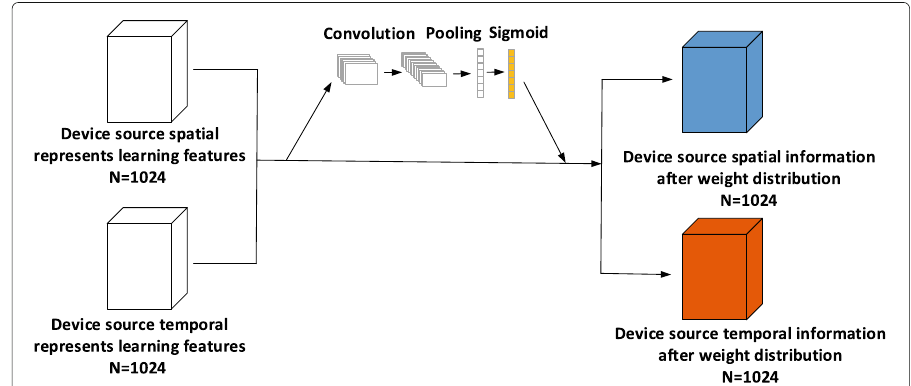
Fig. 5 Schematic diagram of attention mechanism. N represents the dimension of the